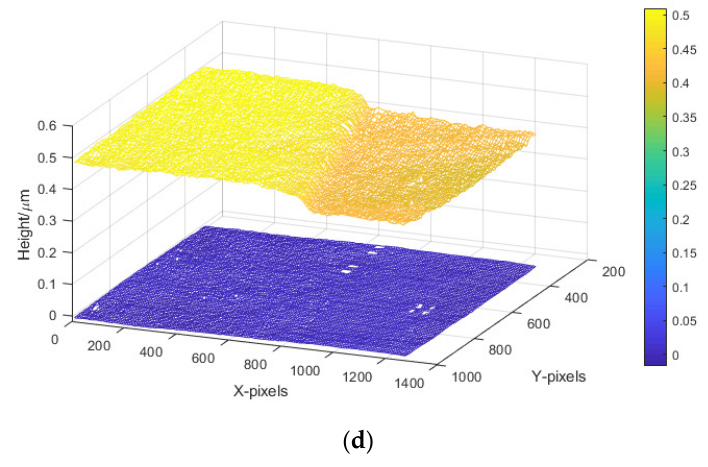
Figure 8. ( a ) Image of junction between areas 1 and 2. ( b ) Cross-sectional morphologies of junctions of different thicknesses. ( c ) Upper and lower surface topographies of the junction of areas 1 and 2 in row 510. ( d ) Surface topographies of pixels in lines 310–1000 of the junction of areas 1 and 2.